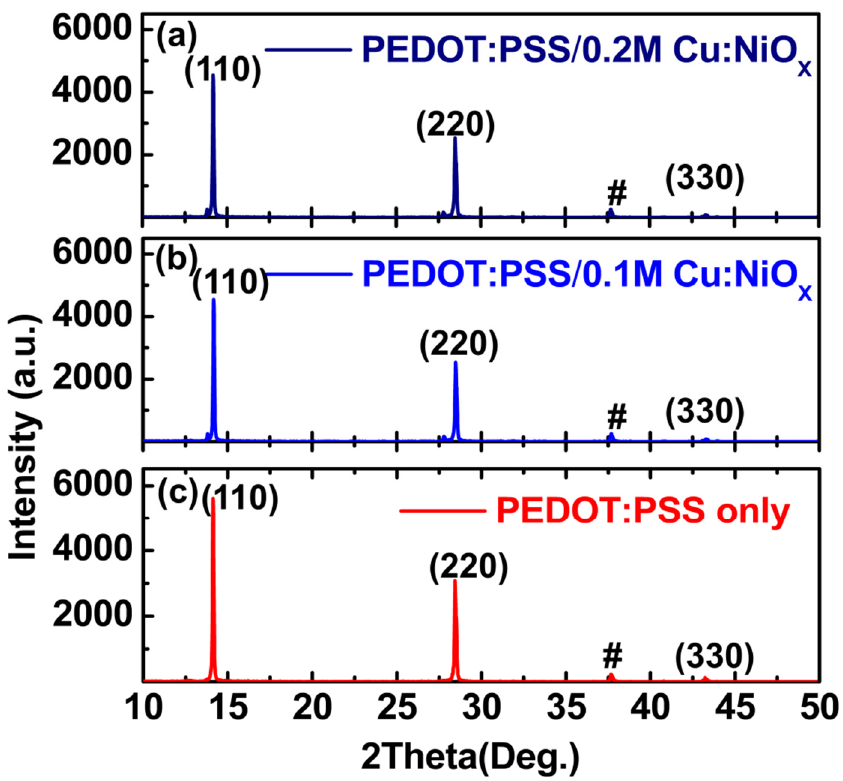
Figure 5. Scanning electron microscopy ( SEM) images of ( a ) perovskite/PEDOT:PSS/FTO/glass, ( b ) perovskite/PEDOT:PSS/0.1 M Cu:NiO x /FTO/glass, ( c ) perovskite/PEDOT:PSS/0.2 M Cu:NiO x /FTO/glass.